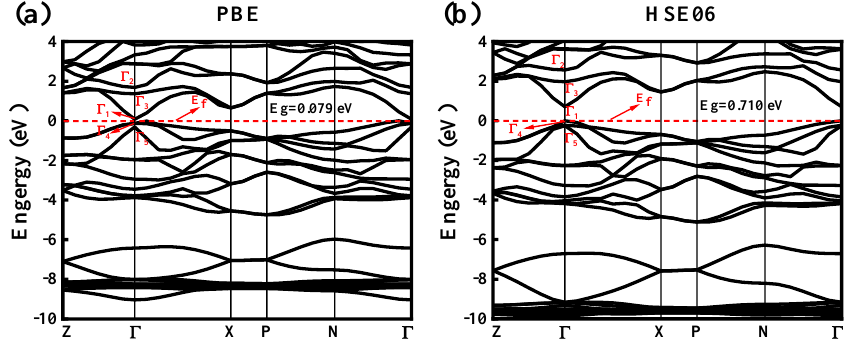
Figure 2. The band structures of CdGeAs 2 . ( a ) GGA–PBE, ( b ) HSE06. Table 2. The characteristic energy values of E V and E C in the BZ of CdGeAs 2 . Method